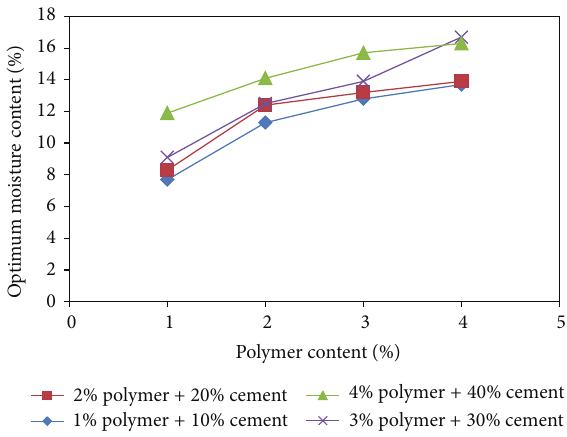
Figure 14: Effect of polymer content on OMC in dry conditions for 15 days.